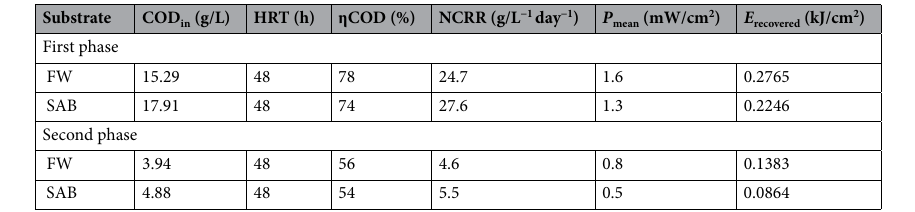
Table 5. Bioelectrochemical performances and energy recovery from the fuel cells during continuous treatment.